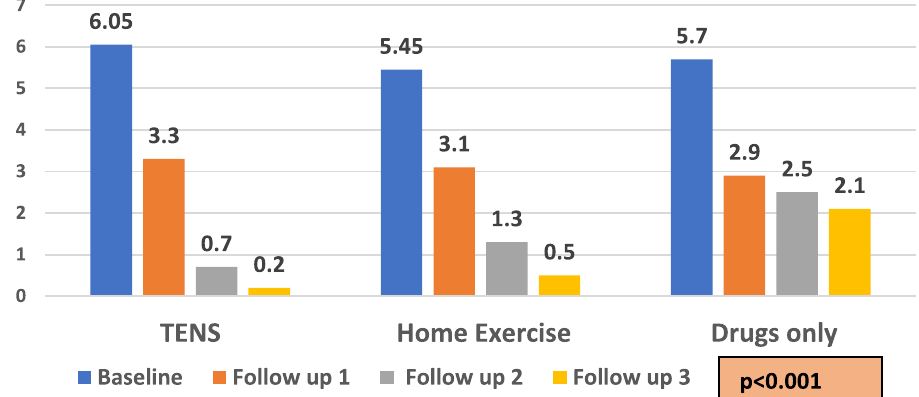
Fig. 1. Intragroup comparison of baseline and post-treatment mean pain scores in Group A, B, and C patients.